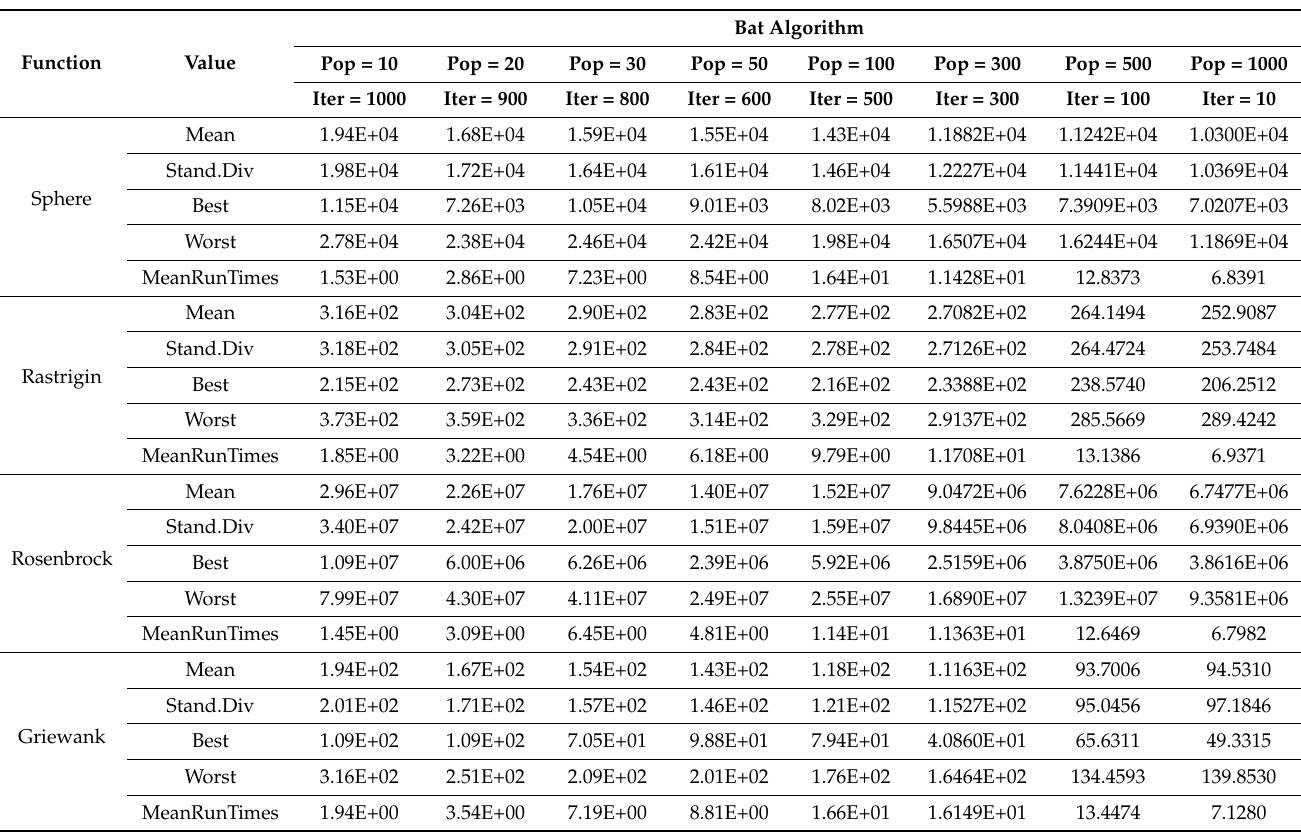
Table 13. Result for Bat